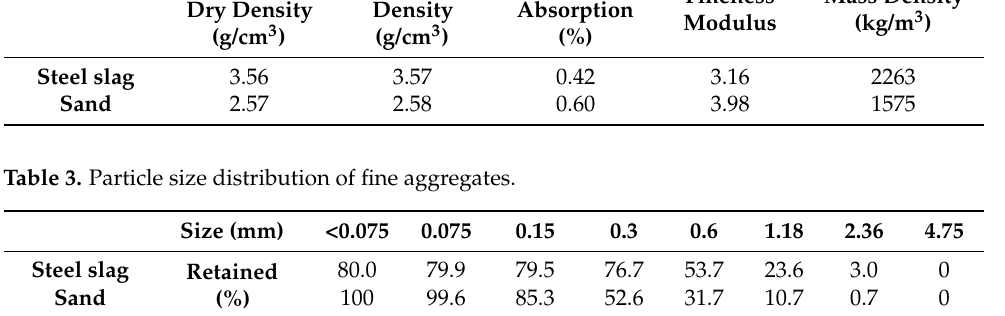
Table 3. Particle size distribution of fine aggregates.